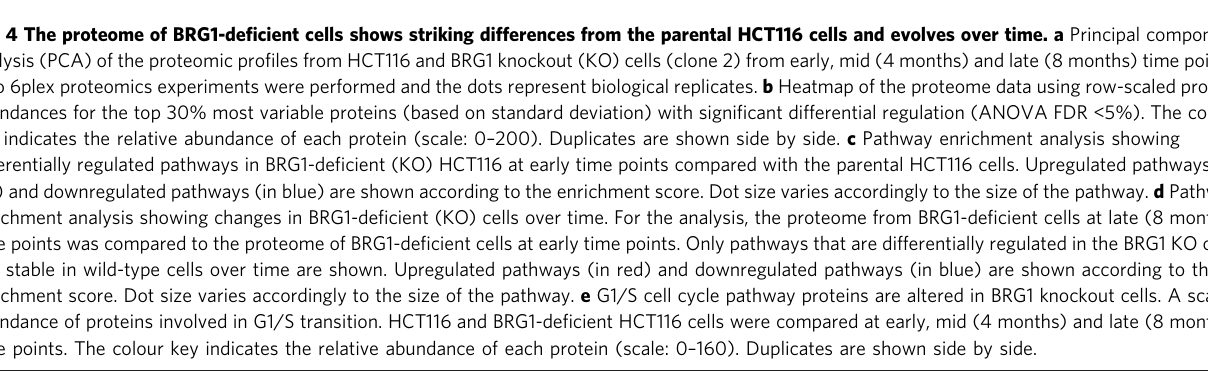
Fig. 4 The proteome of BRG1-de fi cient cells shows striking differences from the parental HCT116 cells and evolves over time. a Principal component analysis (PCA) of the proteomic pro fi les from HCT116 and BRG1 knockout (KO) cells (clone 2) from early, mid (4 months) and late (8 months) time points. Two 6plex proteomics experiments were performed and the dots represent biological replicates. b Heatmap of the proteome data using row-scaled protein abundances for the top 30% most variable proteins (based on standard deviation) with signi fi cant differential regulation (ANOVA FDR <5%). The colour key indicates the relative abundance of each protein (scale: 0 – 200). Duplicates are shown side by side. c Pathway enrichment analysis showing differentially regulated pathways in BRG1-de fi cient (KO) HCT116 at early time points compared with the parental HCT116 cells. Upregulated pathways (in red) and downregulated pathways (in blue) are shown according to the enrichment score. Dot size varies accordingly to the size of the pathway. d Pathway enrichment analysis showing changes in BRG1-de fi cient (KO) cells over time. For the analysis, the proteome from BRG1-de fi cient cells at late (8 months) time points was compared to the proteome of BRG1-de fi cient cells at early time points. Only pathways that are differentially regulated in the BRG1 KO cells and stable in wild-type cells over time are shown. Upregulated pathways (in red) and downregulated pathways (in blue) are shown according to the enrichment score. Dot size varies accordingly to the size of the pathway. e G1/S cell cycle pathway proteins are altered in BRG1 knockout cells. A scaled abundance of proteins involved in G1/S transition. HCT116 and BRG1-de fi cient HCT116 cells were compared at early, mid (4 months) and late (8 months) time points. The colour key indicates the relative abundance of each protein (scale: 0 – 160). Duplicates are shown side